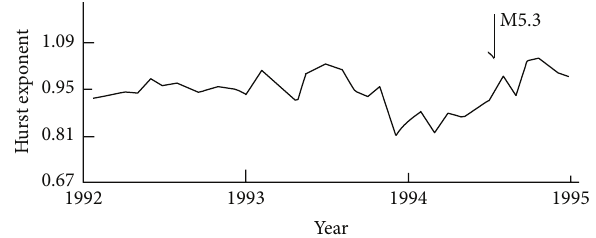
Figure 8: The temporal variation of Hurst exponent before and after the 21 May 1984 Wunansha earthquake